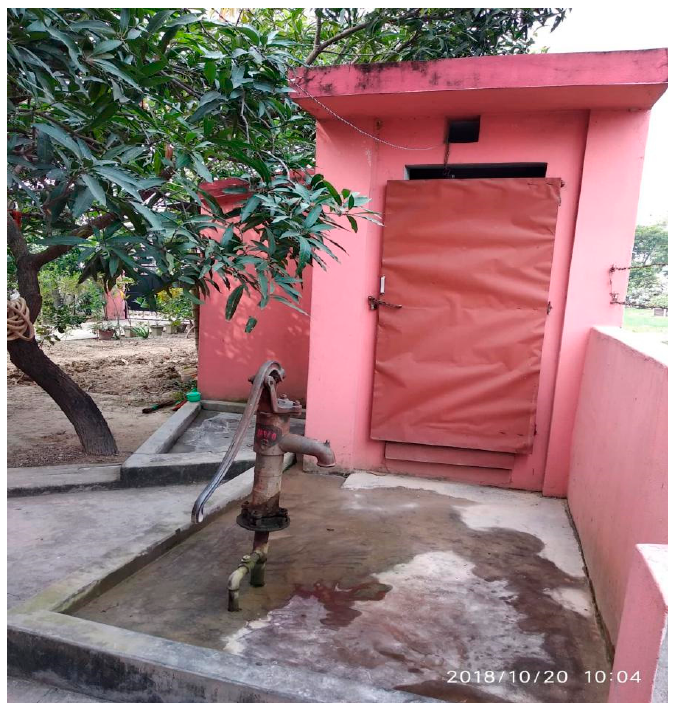
Figure 1. Backyard water source and toilet facility in a typical Nepalese household. Photo credit: Sudeep Sharma.